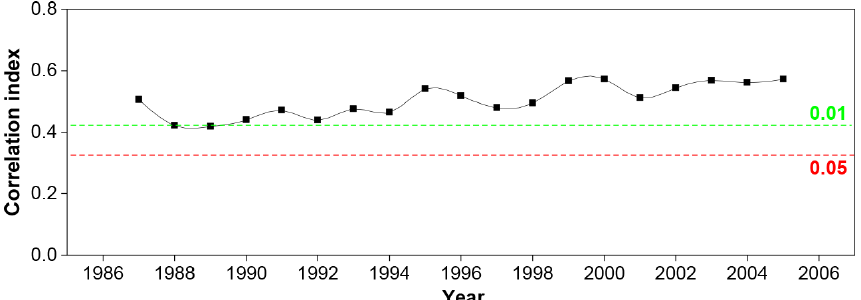
Figure 5. The moving correlation result between TRW chronology and NGS precipitation during the period of 1956–2005. The horizontal red and dashed green lines denote the significance levels of 0.05 and 0.01, respectively.